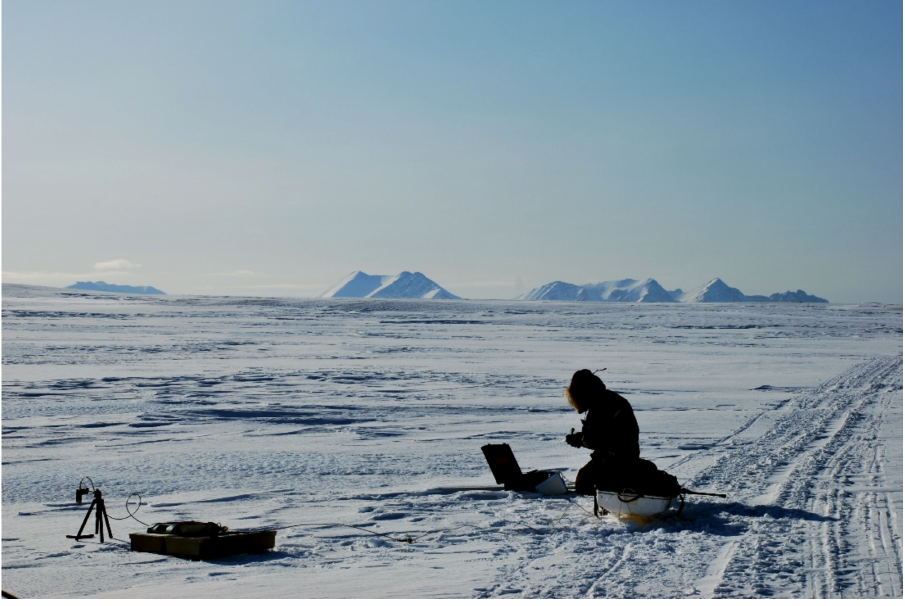
Figure 2. Field hyperspectral observation